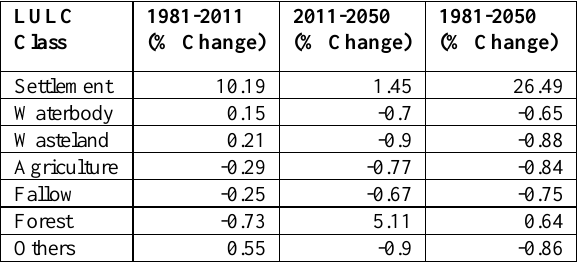
Table 2: Percentage change of LULC from 1981-2050 Figure 8: Predicted LuLc of 2030